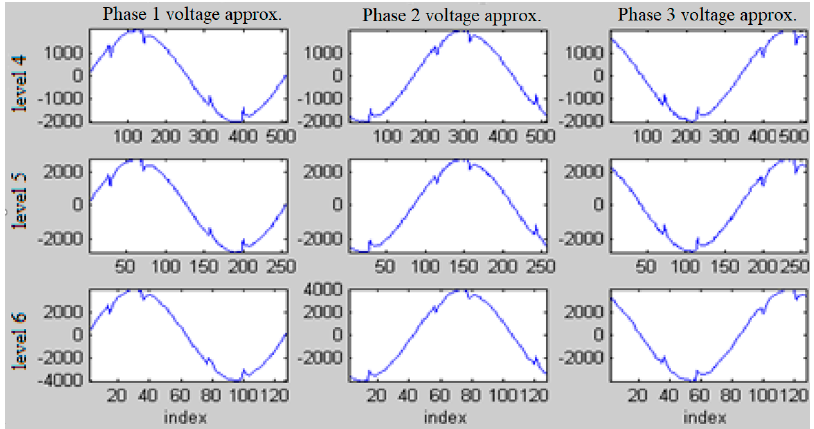
Figure 9. Vectors of details for voltages, levels 4–6, first case study.